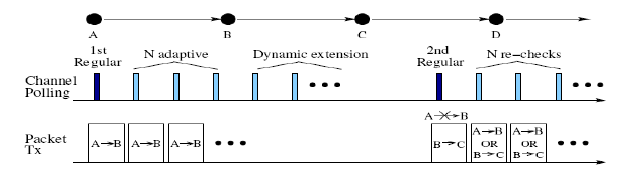
Fig. 2 . Adaptive channel polling proposed by